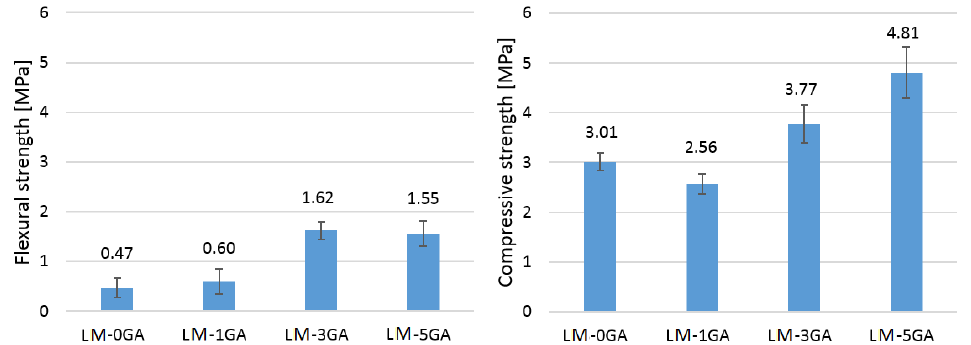
Figure 10. Average values of flexural strength (on the left ) and compressive strength (on the right ) of the tested samples (error bars mean standard deviation).